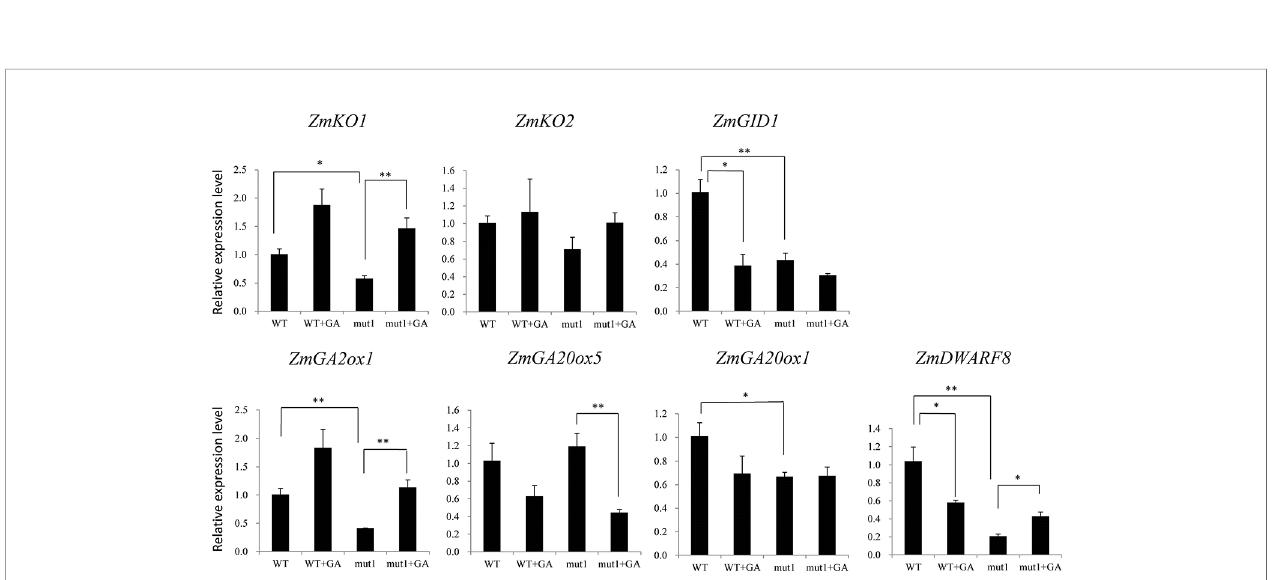
FIGURE 5 | Effect of exogenous GA 3 on gene expression levels in WT and mutant plants. Two week after seedling emergence, the plants were sprayed with 100 mg/L GA 3 one times per day. Shoot samples were collected one week after treatment. Data was shown as average ± S.E. of three independent experiments. Experimental data was tested by student t-test analysis. * and ** indicate signi fi cant differences at the P <0.05 and P <0.01 level, respectively.